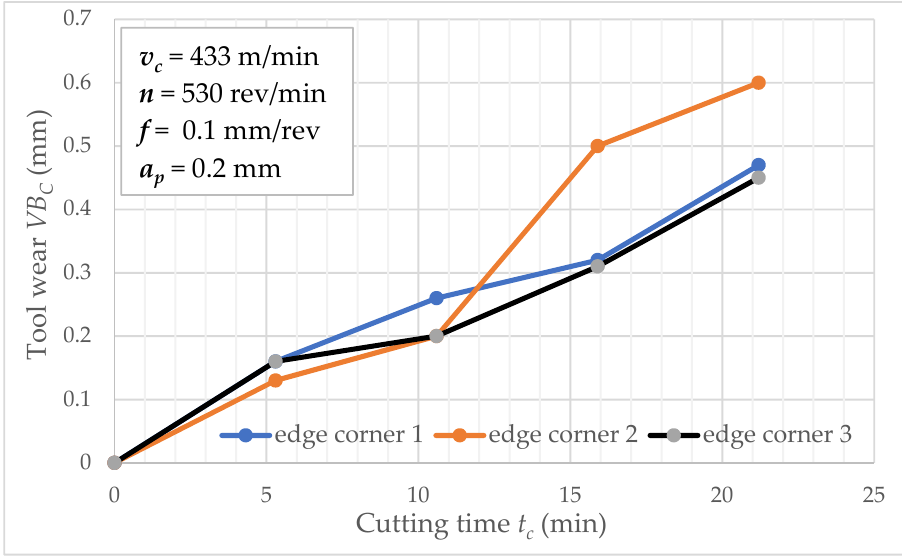
Figure 4. Tool wear VB C as a function of cutting time t c ( v c = 314 m/min).